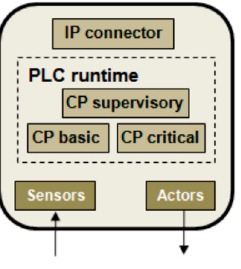
Figure 1. Structure of a PLC as a cyber physical systems (CPS) component.